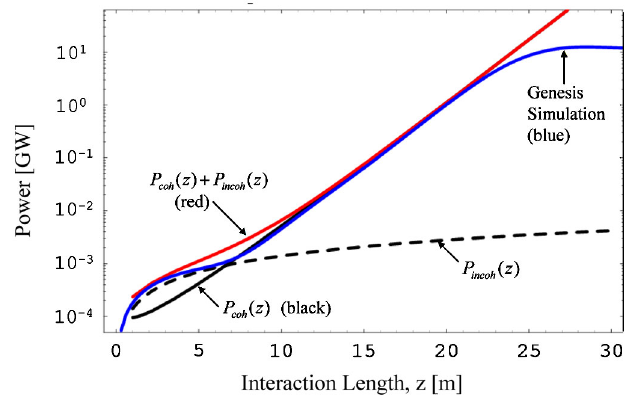
FIG. 7. (Color) Power versus interaction length for the LCLS FEL (cold beam) with parameters listed in Table II. Curves denote coherent power (solid black), incoherent power (dashed), total theoretical power (red), and the result of a GENESIS simu- lation (blue). The theoretical efficiency is (cid:11) ¼ 0 : 046 ð (cid:2) 0 : 07% . The efficiency observed in the GENESIS simulation is 0.08%.